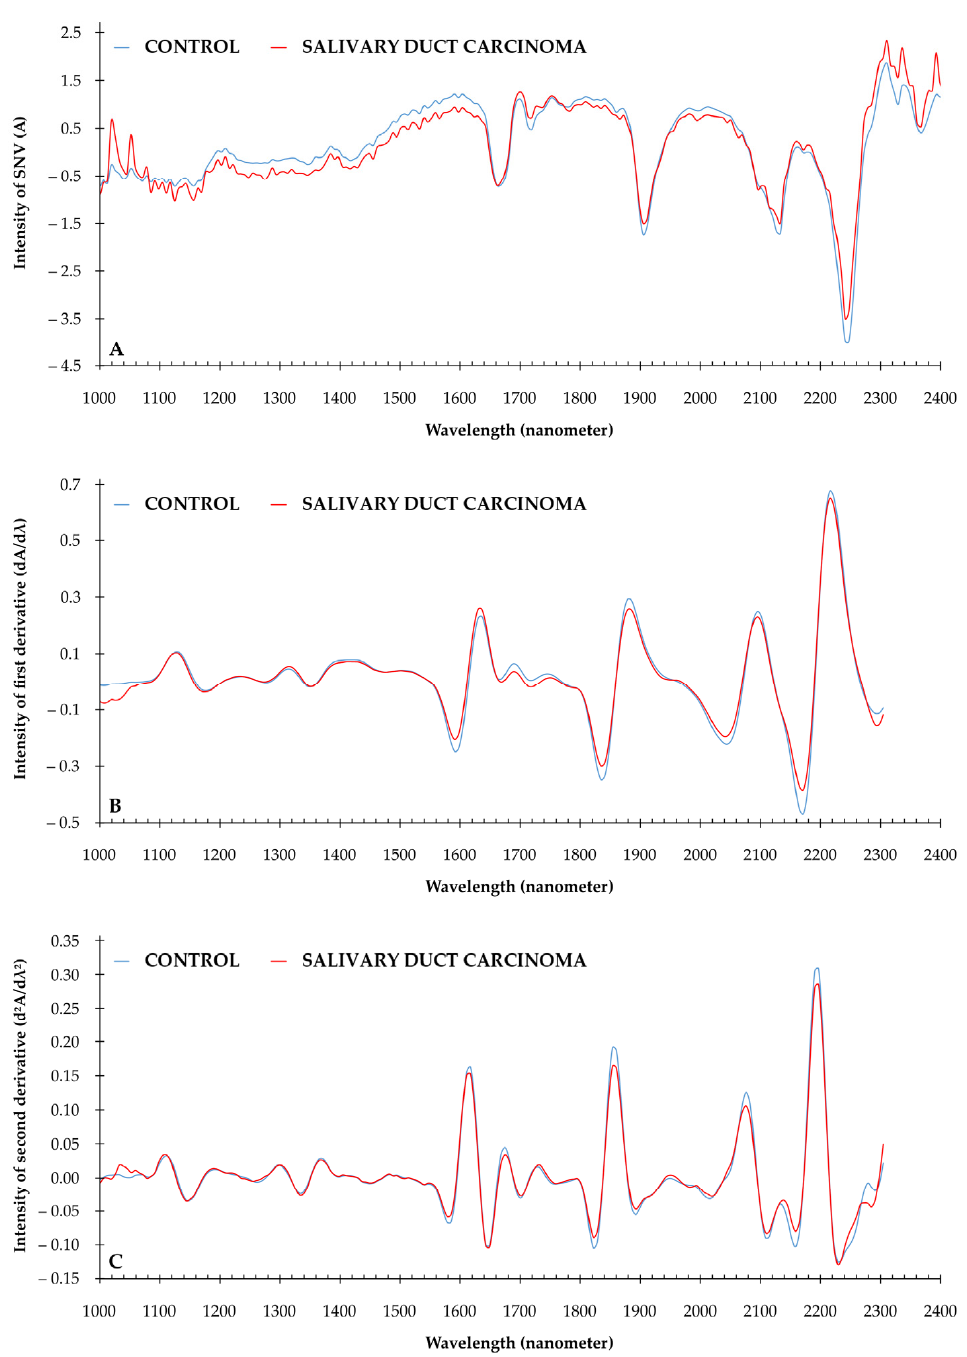
Figure 1. Median NIR spectra for control group and salivary duct carcinoma. Spectral range from 1000 to 2400 nanometer. ( A ) NIR spectra after preprocessing SNV; ( B ) NIR spectra after SNV and S-G smoothing (9 smoothing points) and 1st derivative; ( C ) NIR spectra after SNV, S-G and 2nd derivative.